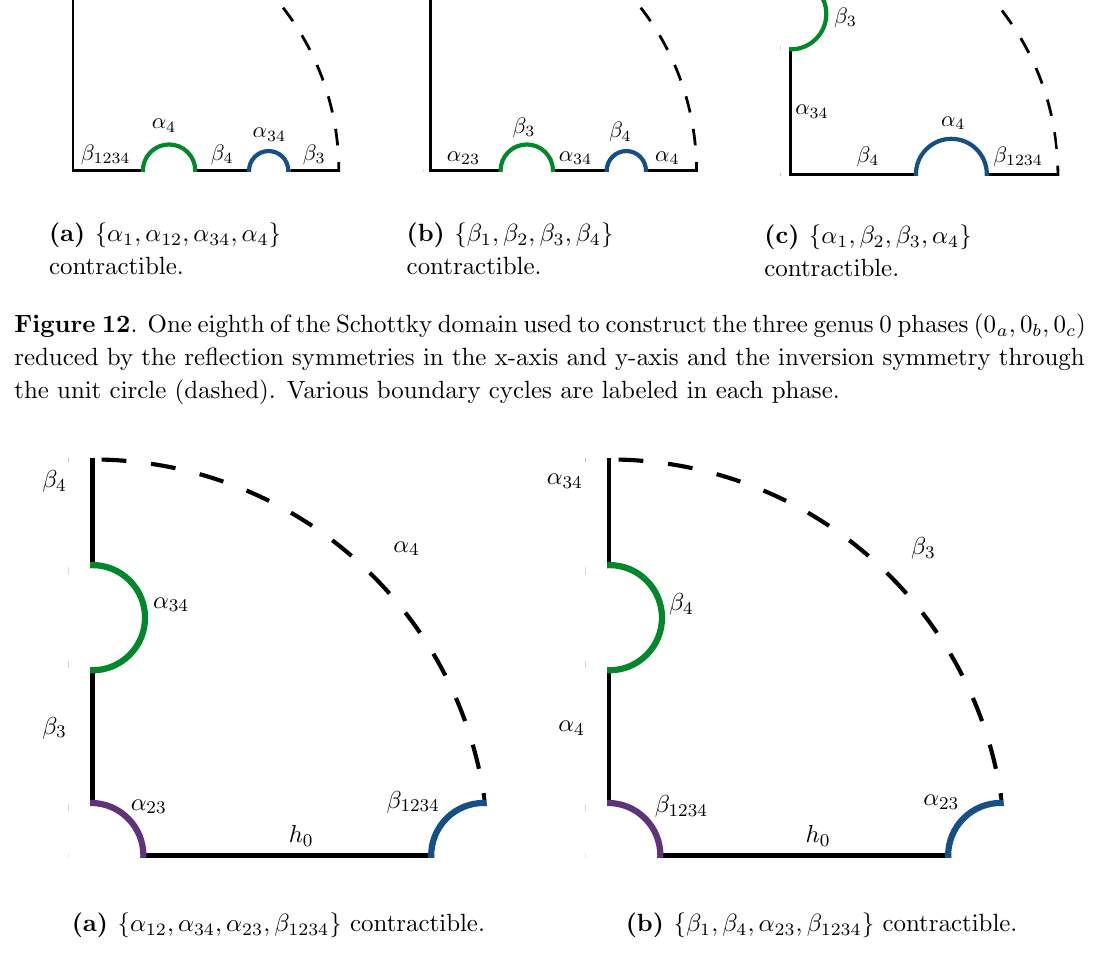
Figure 13 . One eighth of the Schottky domain used to construct the two genus 1 phases (1 a ; 1 b ) reduced by the re(cid:13)ection symmetries in the x-axis and y-axis and the inversion symmetry through the unit circle (dashed). Various boundary cycles are labeled in each